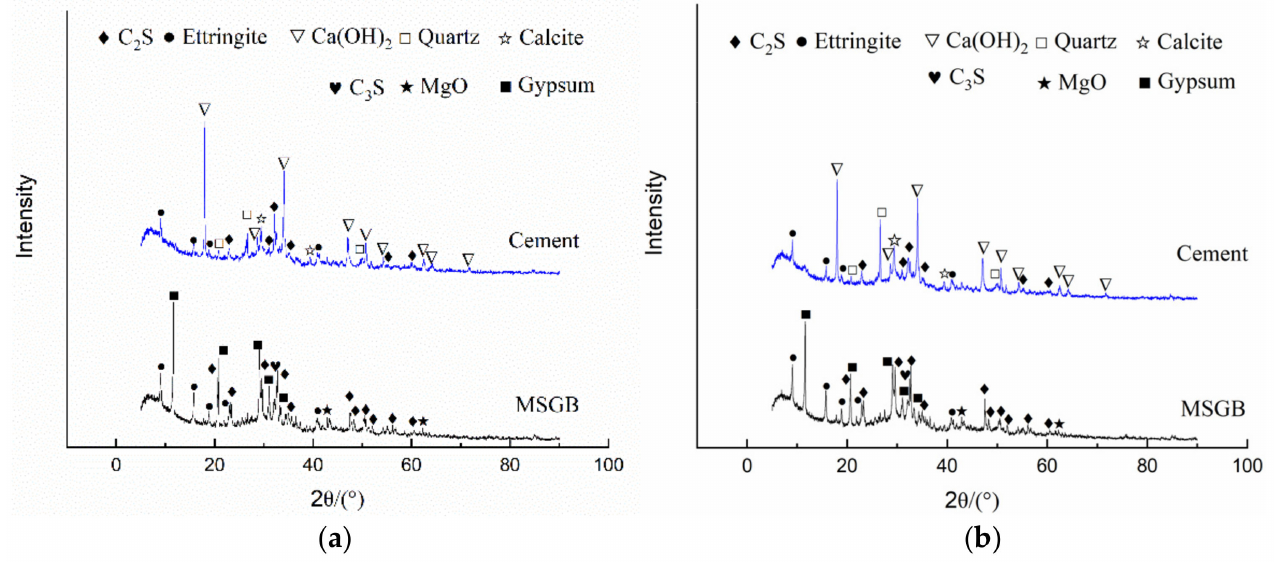
Figure 5. XRD patterns of MSGB and cement. ( a ) 7 d. ( b ) 28